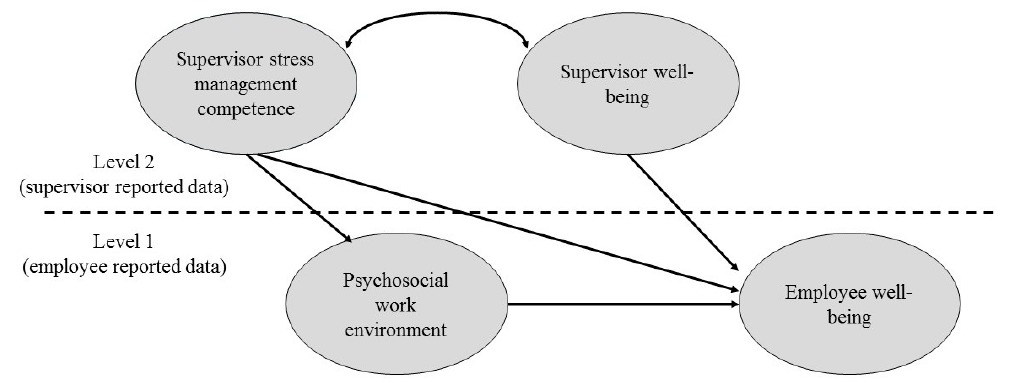
Figure 1. The study´s conceptual model . Figure 1. The study’s conceptual